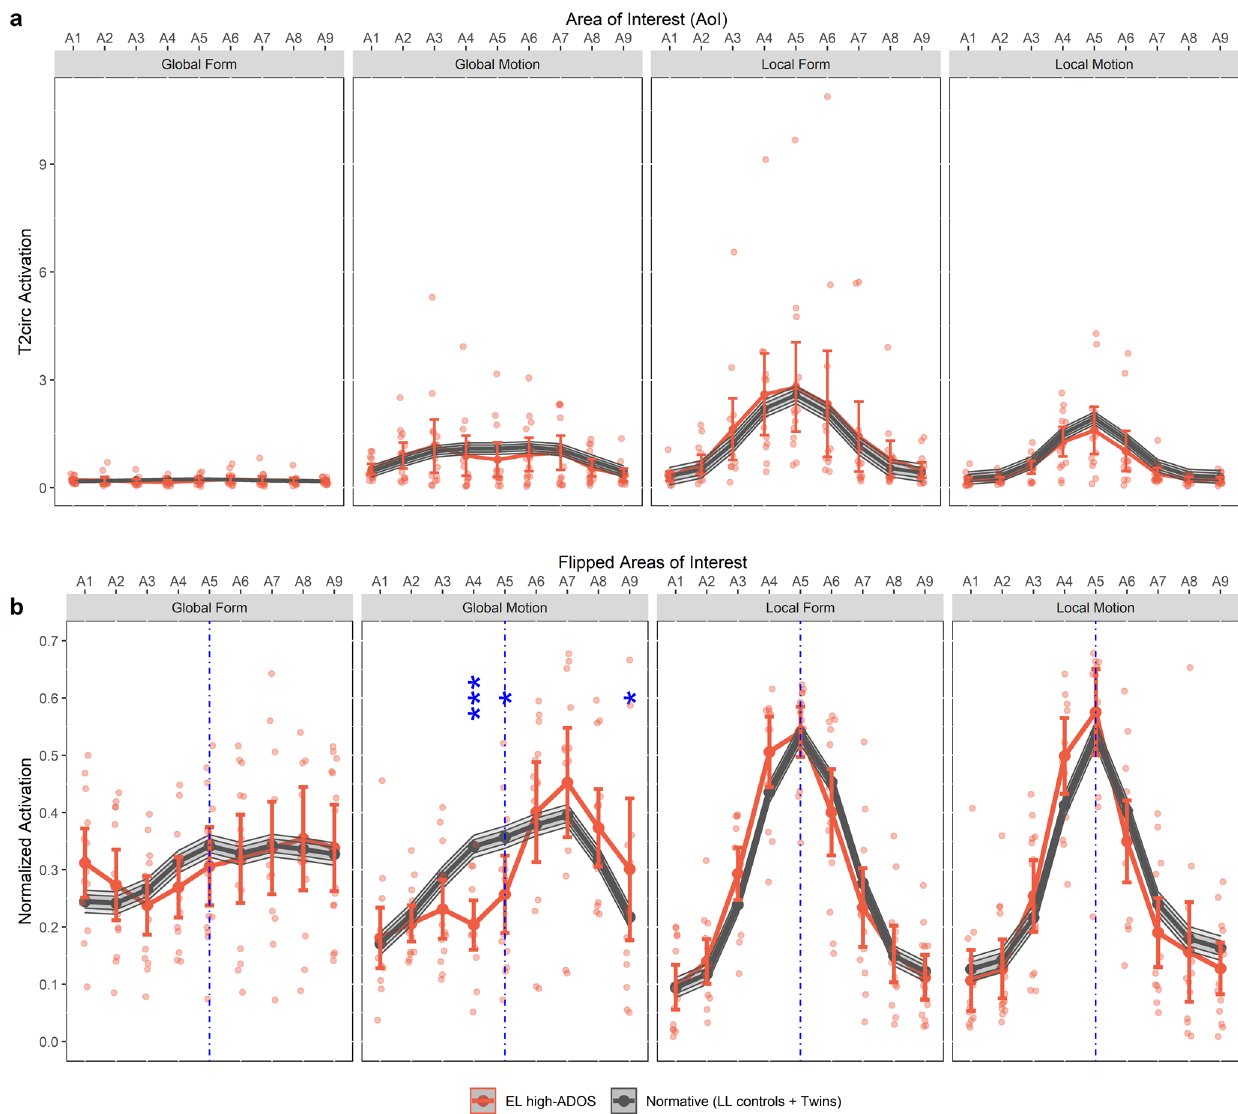
Fig. 4 Nominal (unnormalized) and unilaterality of visual cortex activation during the four stimulus conditions. a The non-normalized version of plots in Fig. 2c, showing the actual T 2 circ activation values for all the four stimulus conditions. No quanti fi able difference was evident between the Normative Sample and EL high-ADOS group in any of these conditions (all p > 0.50). Furthermore, the strength of activation during global form processing was so much weaker compared the other three conditions, suggesting the relative immaturity of this perceptual function at 5 months of age, in line with previous fi ndings (e.g., refs. 16,17,29 ) in the literature. b . The same plots (Fig. 2c) with the order of the nine AOIs reversed for some of the infants such that all the peak activations now lie on the same side (the right side, arbitrarily chosen). The term fl ipped AOIs in the fi gure refers to this rearrangement for some infants. As in the main result (Fig. 2c), midline activations (AOIs A4 and A5) were signi fi cantly weaker in EL high-ADOS (*** p < 0.001, d = 0.12, and * p = 0.018, d = 0.09, respectively), while the extreme lateral activation (AOI A9) was stronger in EL high-ADOS (* p = 0.048, d = − 0.07). Data from the Normative Sample group ( n = 473) is plotted as mean, 95%-C.I. (inner band, darker shade) and 99.5%-C.I. (outer band, lighter shade). Data from the EL high-ADOS group ( n = 14) is plotted as mean and 95%-C.I. (error bars) along with the individual data points. Con fi dence intervals for the Normative Sample group are comparatively very small due to its much bigger sample size. See also Supplementary Fig. 2 for more detailed AOI activation plots of the Normative Sample group and Supplementary Table 1 for complete